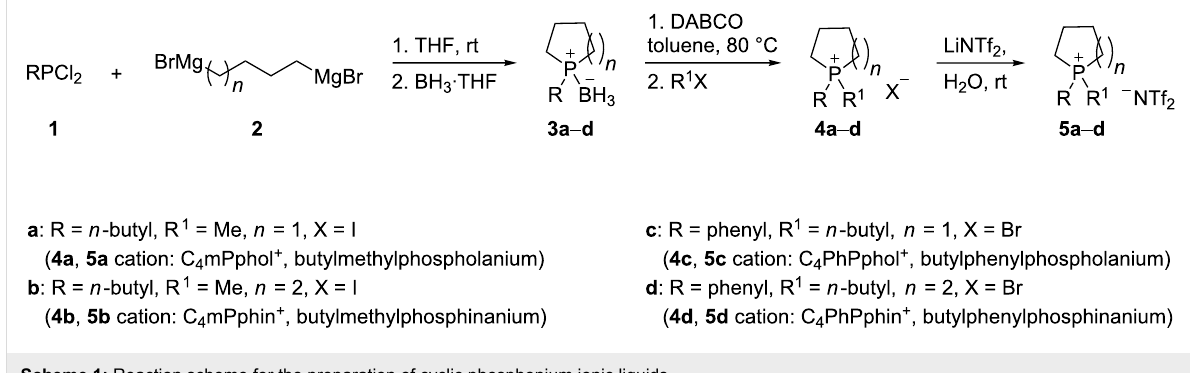
Scheme 1: Reaction scheme for the preparation of cyclic phosphonium ionic liquids.